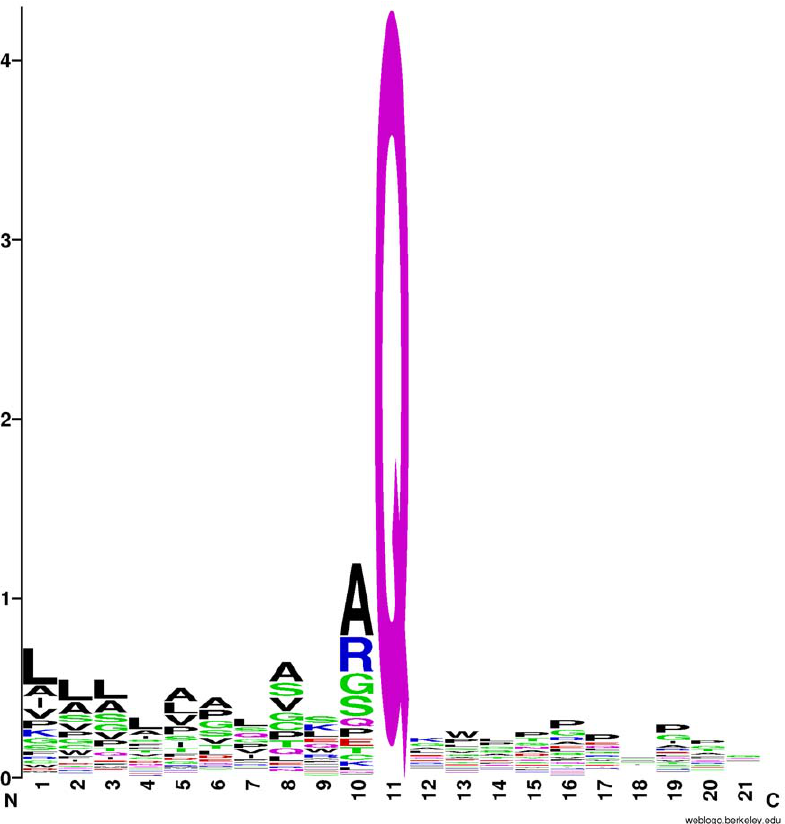
Figure 8. The sequence logo of 370 21-residue peptides [ 49 ] . In the upstream of Q site, sites 1, 2, 3, 5, 8 and 10 show some degree of conservation.